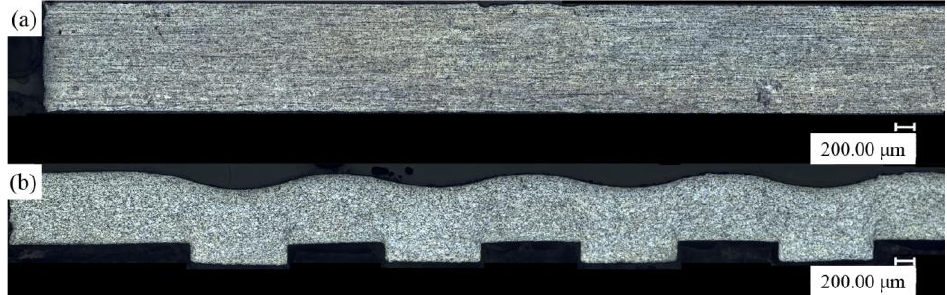
Figure 14. Overall metallographic structure of the pipe. ( a ) Before Forming. ( b ) After Forming.